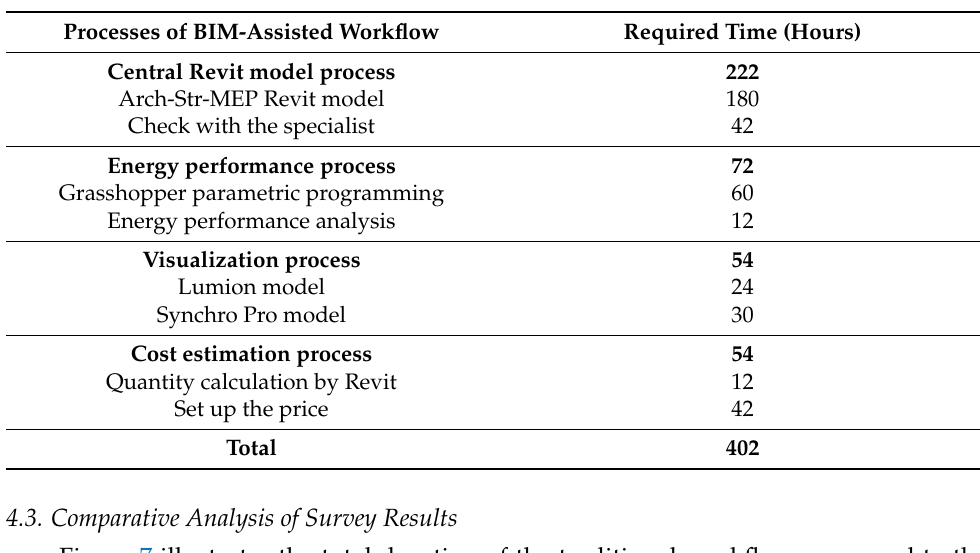
Figure 8. Central Revit model of a parking lot. 4.4.2. Energy Performance Process